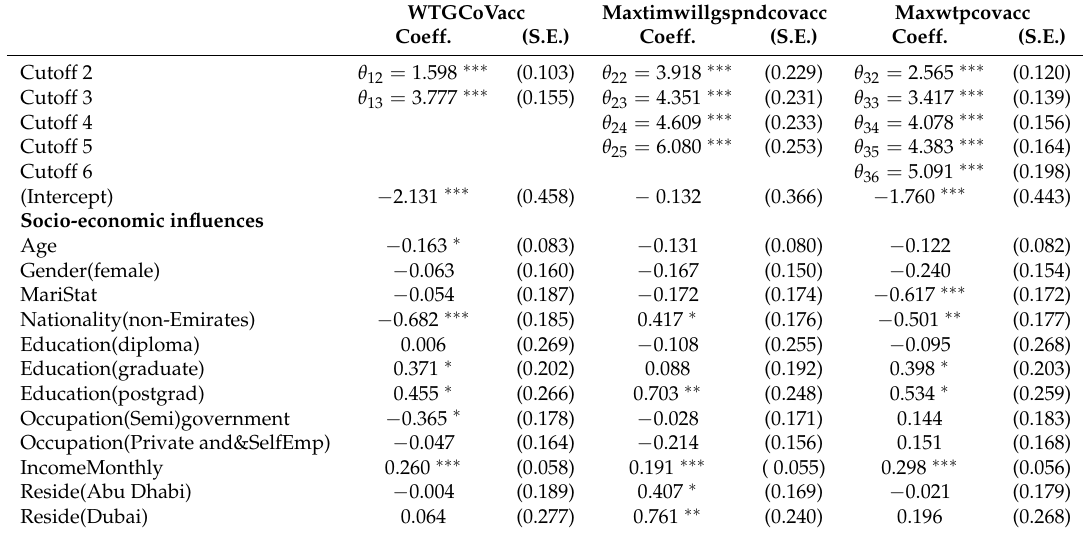
Table A7. Maximum Composite Likelihood estimates of the Multivariate Logit Model